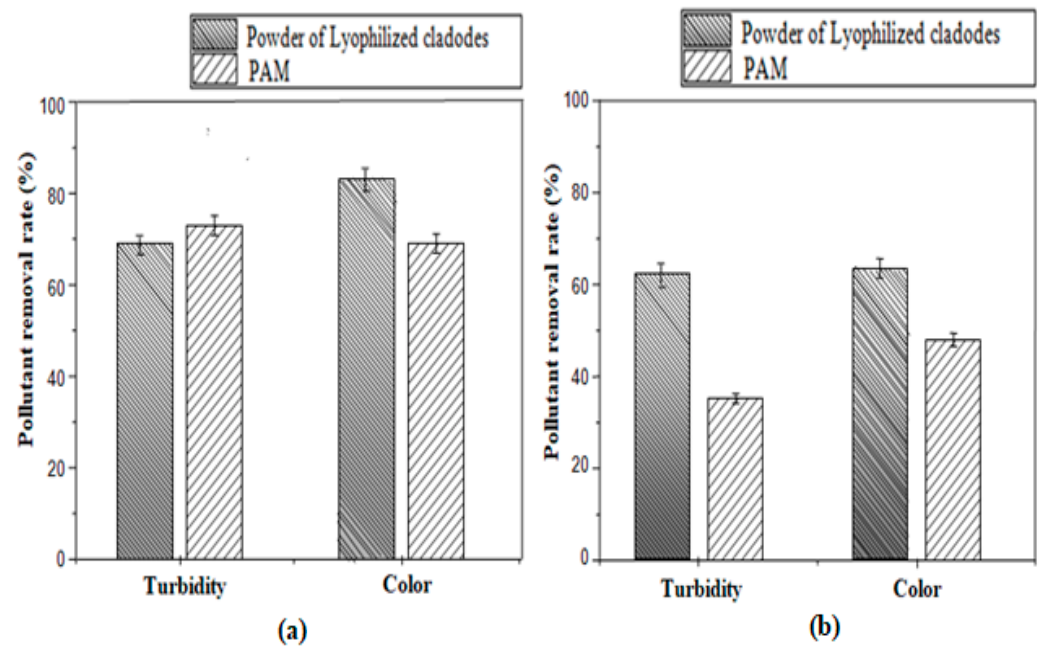
Figure 8. Turbidity and color removal using the natural flocculant (LP) and the chemical flocculant (polyacrylamide (PAM)) for MB ( a ) and MO ( b ) solutions with the optimized doses (Dyes concentration = 0.10 g / L, coagulant dose = 0.30 g / L, LP = 0.37 g / L, PAM = 0.004 g / L).